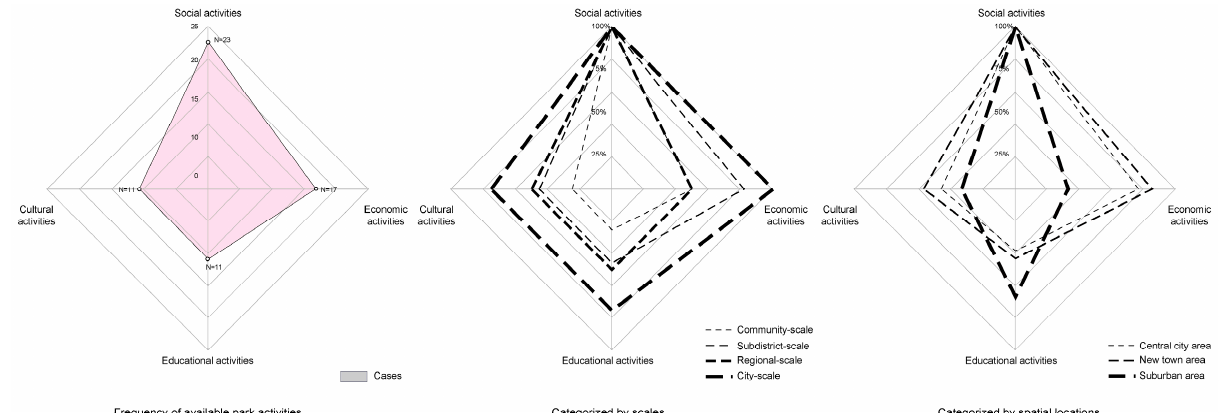
Figure 5. The implementation of park